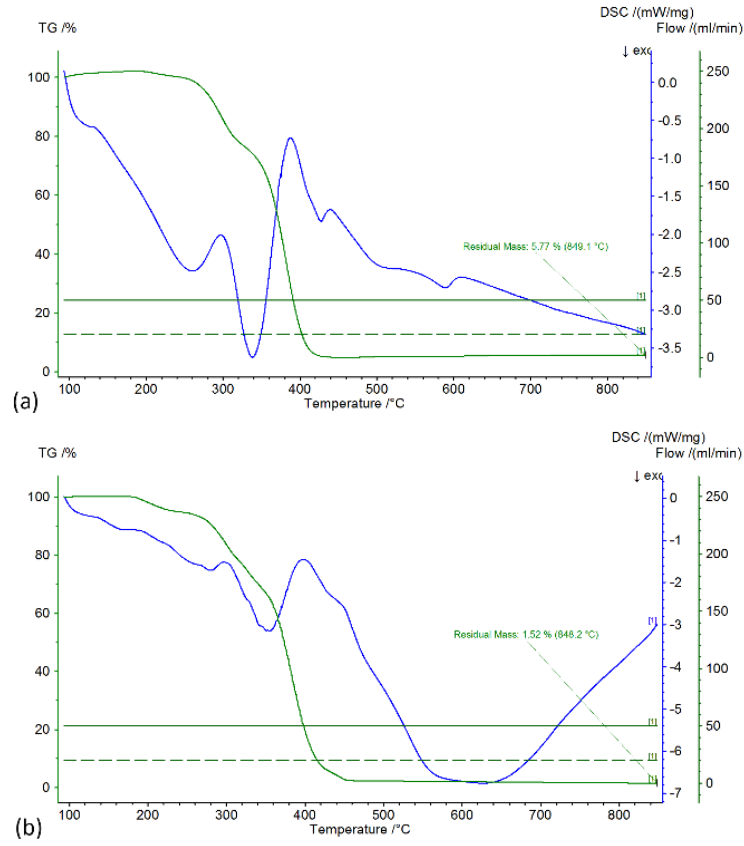
Figure 4. TGA/DSC graphs of the produced PMMA core ( a ) and PMMA@P(MAA-co-EGDMA) core- Figure 4. TGA / DSC graphs of the produced PMMA core ( a ) and PMMA@P(MAA-co-EGDMA) core-shell shell copolymer ( b ). copolymer ( b